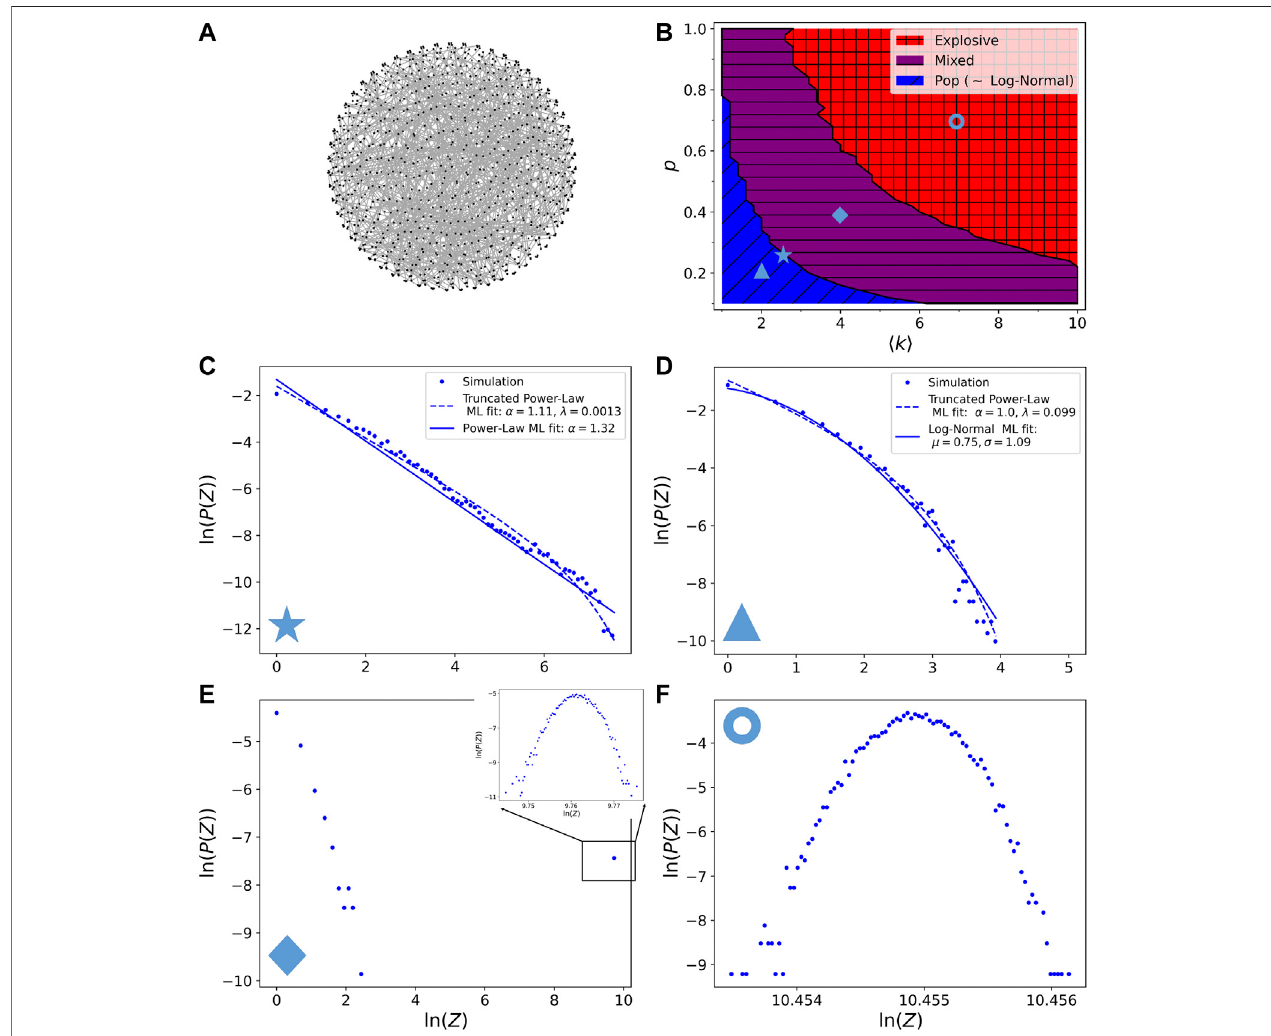
FIGURE3|(A) Pictureoftherandomnetworkmodel,embeddedinasphere.Noticethatthisisjustachoiceofrepresentation,theshapeofthenetworkisnot fi xed: our networkmodel isonly aset ofconnections, itcanbe embedded in any metric space.Dots are thenodes ofthe networkand lines arethe links. Forbetter visibility the network has here only N (cid:1) 1000 nodes and a probability of connection p l (cid:1) 0 . 003; (B) Phase diagram of the possible resulting avalanche size distributions with respect to the model parameters 〈 k 〉 (the average number of connections of the network) and p (the probability of breaking a link). The three identi fi ed regimes are: pop (blue), which has an avalanche distribution statistically compatible with a log-normal tail; mixed (purple) where a mixture of the two different behaviors, i.e., big large size avalanchesandpopavalanches,areobservedatthesametime; explosive (red)wherealmostonlybigavalanchesspanningallthenetworksizeareobserved.Fordetails aboutthedetectionofthetransitionsbetweenregimesseetext.Thenumberofnodesofthenetworkis N (cid:1) 10000andthestatisticsisdoneoutof n (cid:1) 10000repetitions. Symbols indicate the points taken to show some distribution examples in the remaining panels. Star has coordinates ( 2 . 6 , 0 . 26 ) , triangle ( 2 , 0 . 2 ) , diamond ( 4 , 0 . 4 ) and doughnut ( 7 , 0 . 7 ) ; (C) Avalanchesizedistributionexactlyatthetransitionbetween pop and mixed .Atthistransitionthedistributionisapower-lawforarangeofalmost3 decades,more preciselythedistributionisatruncatedpower-law, giventhe fi nitesizeofthesystem.Dotsshow thesimulation distribution andthedashed (resp. full)line showsthemaximumoflikelihood fi twithatrucatedpower-law(resp.power-law)distribution; (D) Avalanchesizedistribution inthe pop regime.Dotsshowthesimulation distribution and the full (resp. dashed) line shows the maximum of likelihood fi t with a log-normal (resp. truncated power-law) distribution; (E) Typical distribution in the mixed , regime, the inset shows a zoom on the distribution of large size avalanches not visible in the main panel; (F) Typical distribution in the explosive regime.